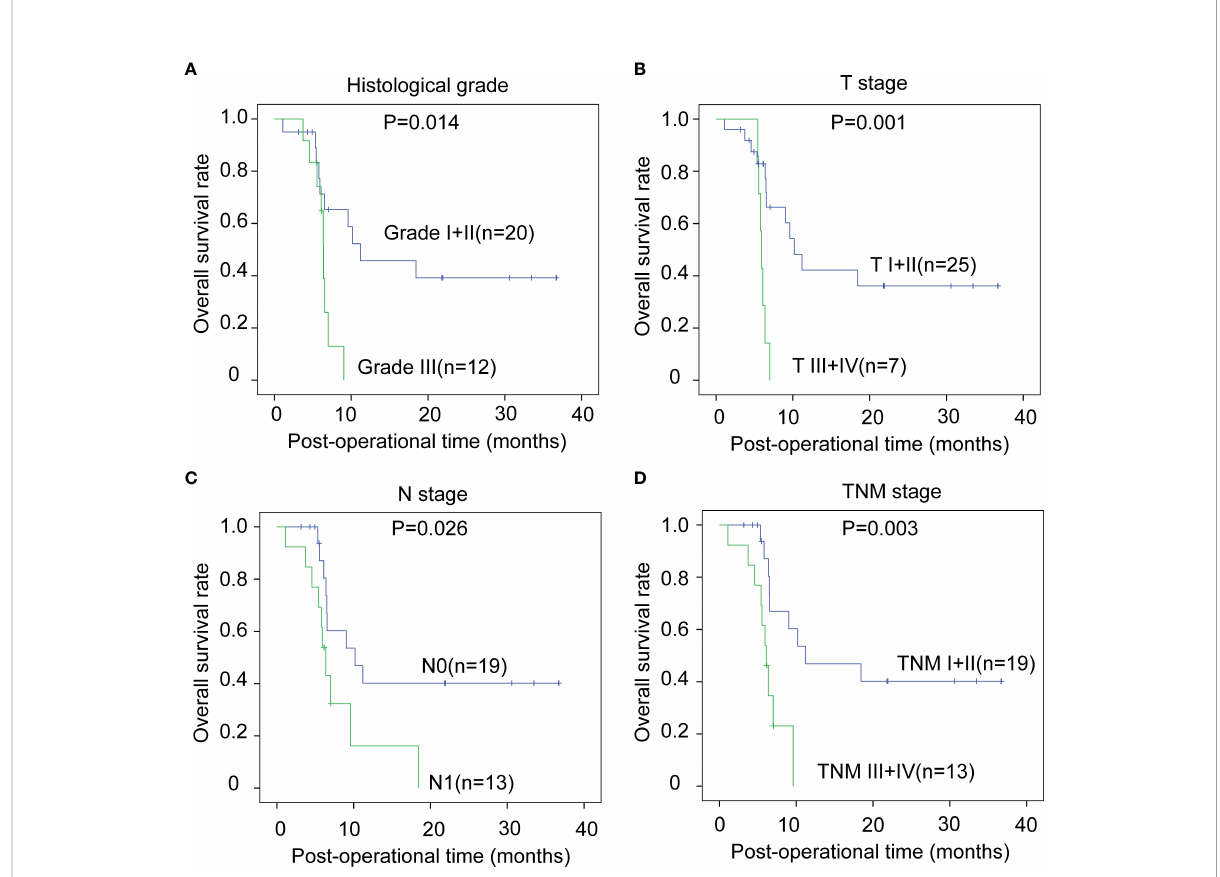
FIGURE 3 The prognostic signi fi cance of clinicopathological factors in iCCA. In iCCA, the prognosis-relevant factors included histological grade (A) , T stage (B) , N stage (C) , and TNM stage (D) . The statistical signi fi cance between subgroups was analyzed with the log-rank